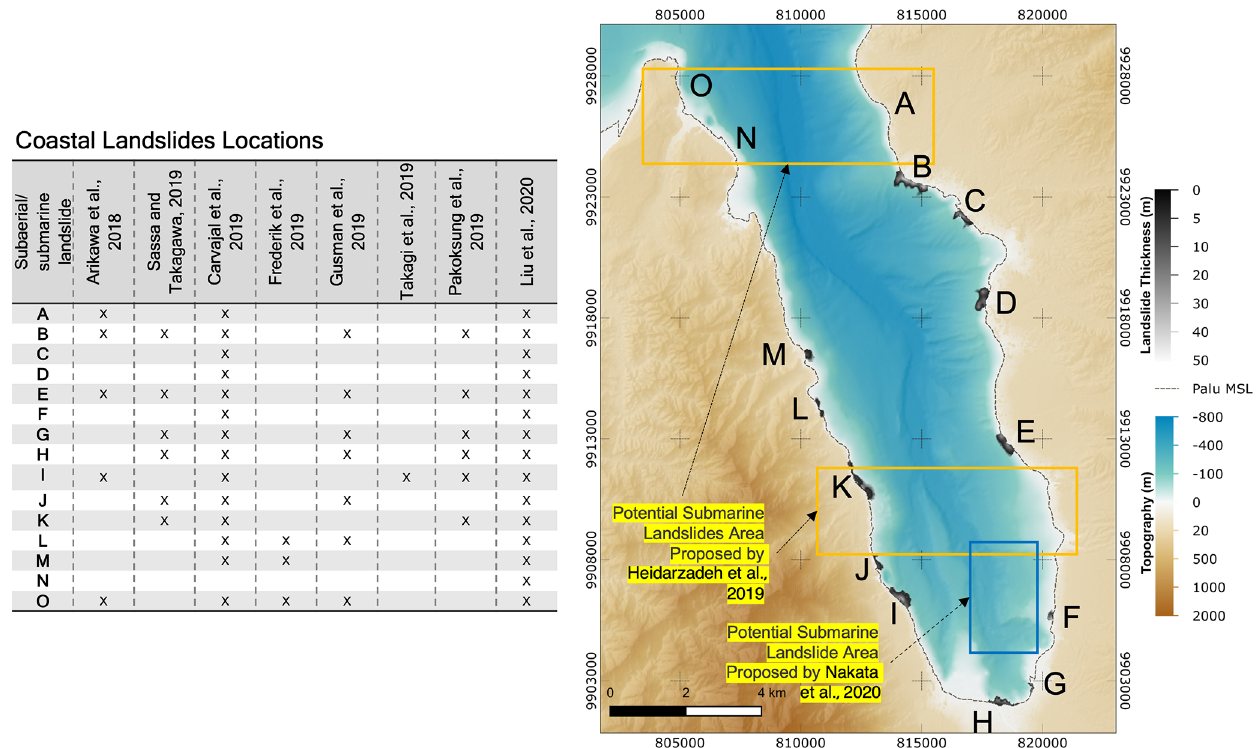
Figure 1. Literature review of observed landslides: A–O represents the locations of observed coastal landslides, and the table summarizes landslides used/proposed in each study. The areas defined by yellow rectangles depict the potential submarine landslide areas proposed by Heidarzadeh et al. (2019), and the blue rectangle depicts the potential submarine landslide area proposed by Nakata et al.